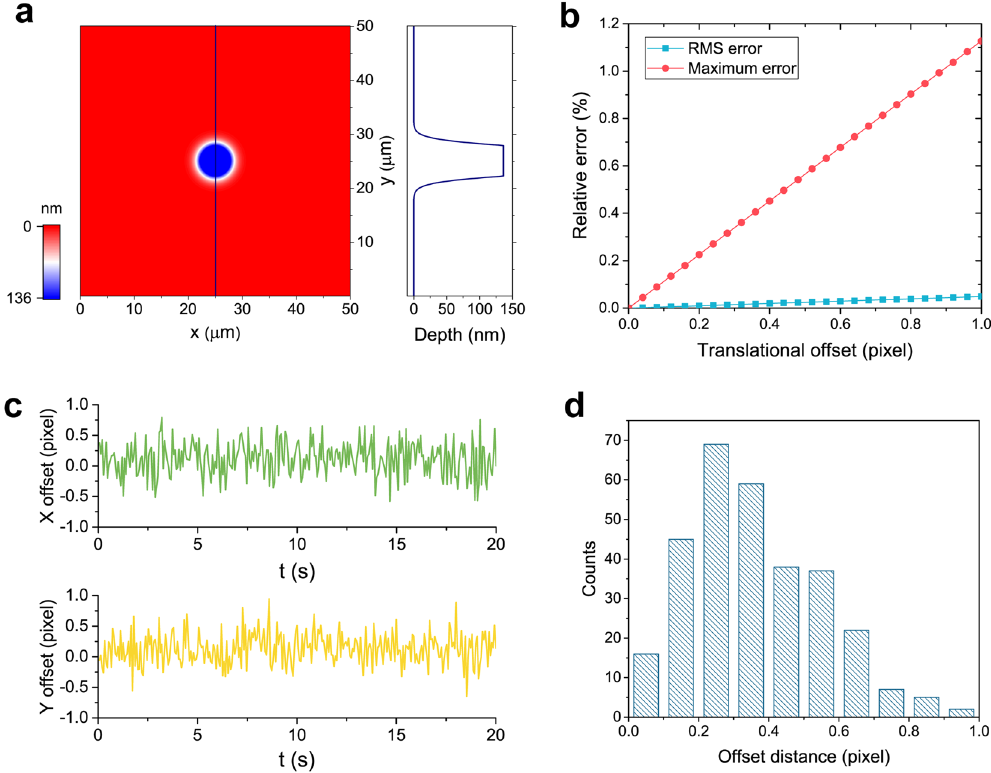
Figure 5. Error analysis of the translational offset and the vibration between the two cameras. ( a ) Modeling of the circular phase target with the diameter of 12 μ m and the etching depth of 136 nm on a fused quartz substrate. ( b ) Simulation result of the relative phase retrieval error due to the translational offset between the two cameras. ( c ) Translational offsets in the x and y directions changing with time due to the environmental vibration in 20 seconds. ( d ) Histogram of the offset distance which is calculated from the translational offsets in the x and y directions in 20